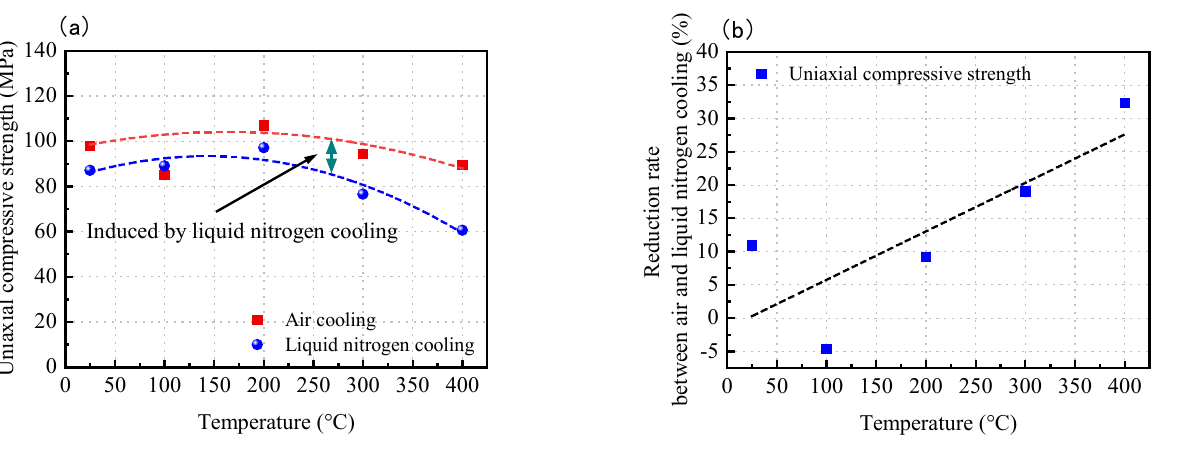
Figure 4. Effect of liquid nitrogen cooling on uniaxial compressive properties: ( a ) uniaxial compres- sive strength and ( b ) reduction rate of compressive strength between air and liquid nitrogen cooling.